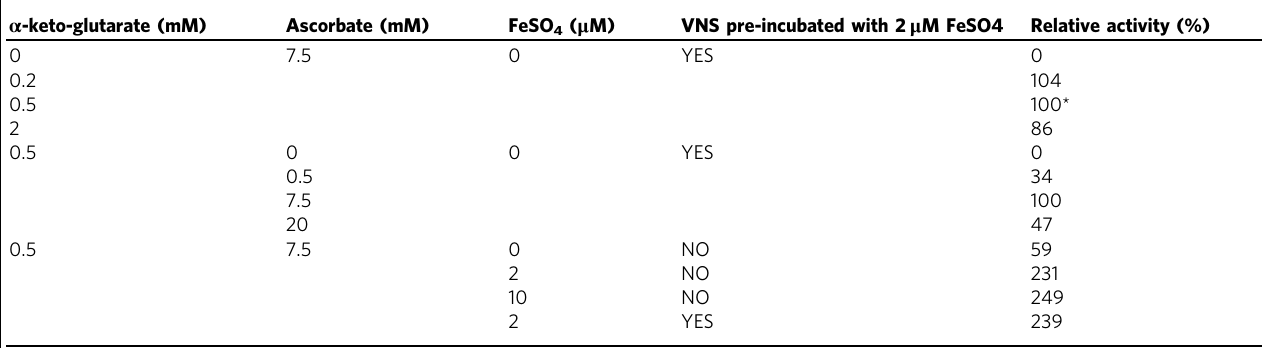
* Standard reaction condition used in this study. Relative activity is de fi ned as the relative amounts of vindolinine epimers and venalstonine produced in other conditions when compared to the standard reaction in 1hr reaction